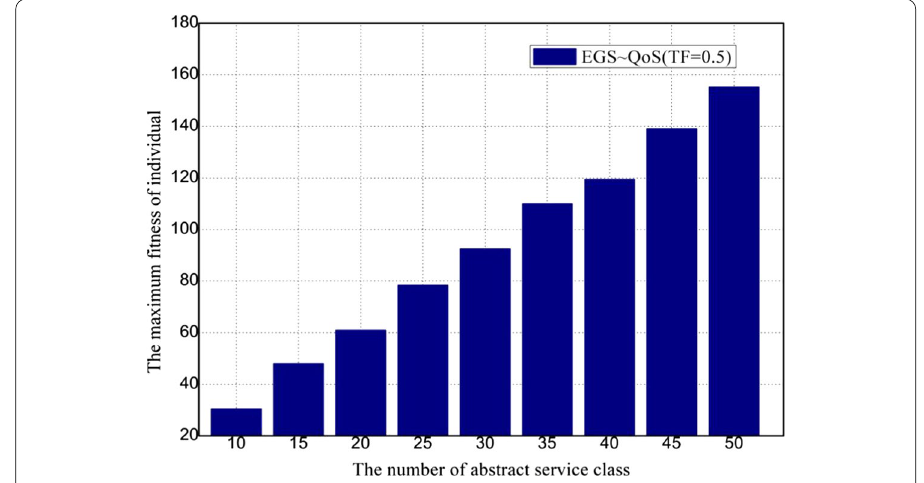
Fig. 6 Maximum fitness of individual in different number of abstract service class